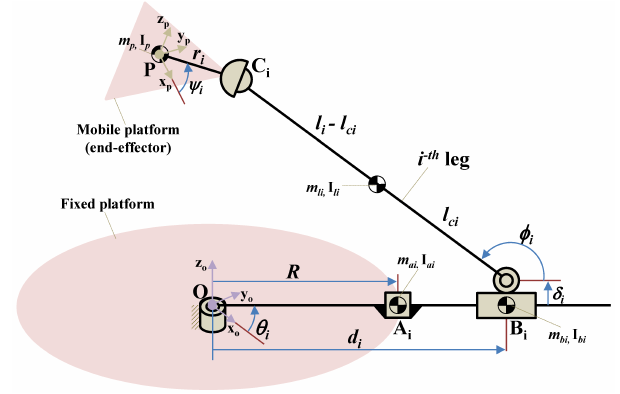
Figure 2. Kinematic arrangement of i th leg of the proposed manip-